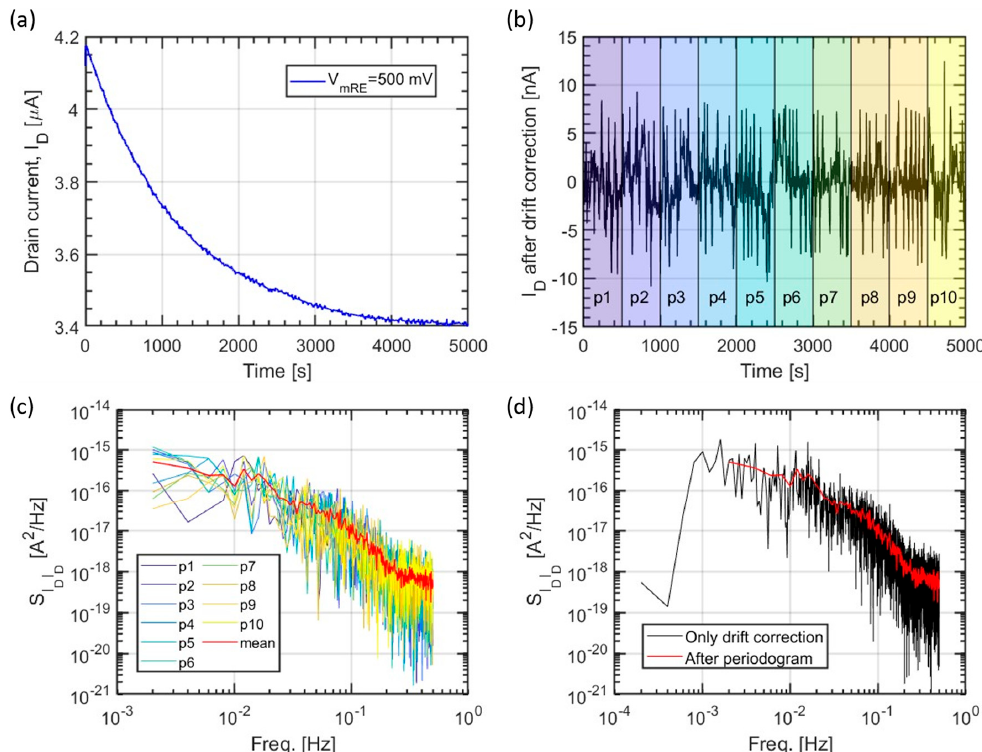
Figure 5. Example of post-processing a drain current waveform measured with sampling time T S = 1 s and V mRE = 500 mV. ( a ) The measured raw waveform of the drain current vs. time. ( b ) The same waveform after drift removal using a 10th order polynomial function and subdivision in ten portions (colored areas) for the application of the periodogram technique. ( c ) Power spectral density (PSD) of each portion of the drift-corrected drain current waveform in ( b ) with a red line showing the average between all the PSDs, i.e., the periodogram. ( d ) Comparison of the PSDs with data cleaned with only the drift correction and data cleaned with both drift correction and periodogram.